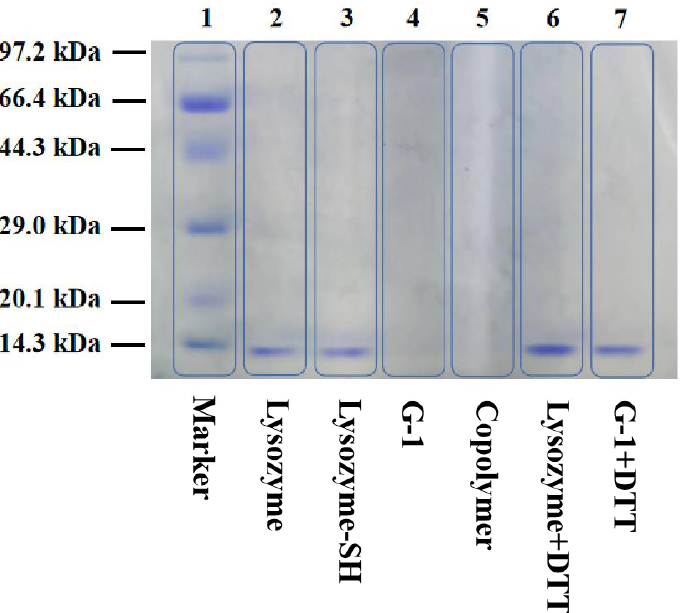
Figure 3. Polyacrylamide gel electrophoresis (SDS-PAGE) results: lane 1: marker; lane 2: lysozyme; lane 3: lysozyme-SH; lane 4: G-1; lane 5: h 1 P(DEGMA- co -OEGMA)- star -PDSMA 45 ; lane 6: lysozyme + DTT; lane 7: G-1 + DTT.